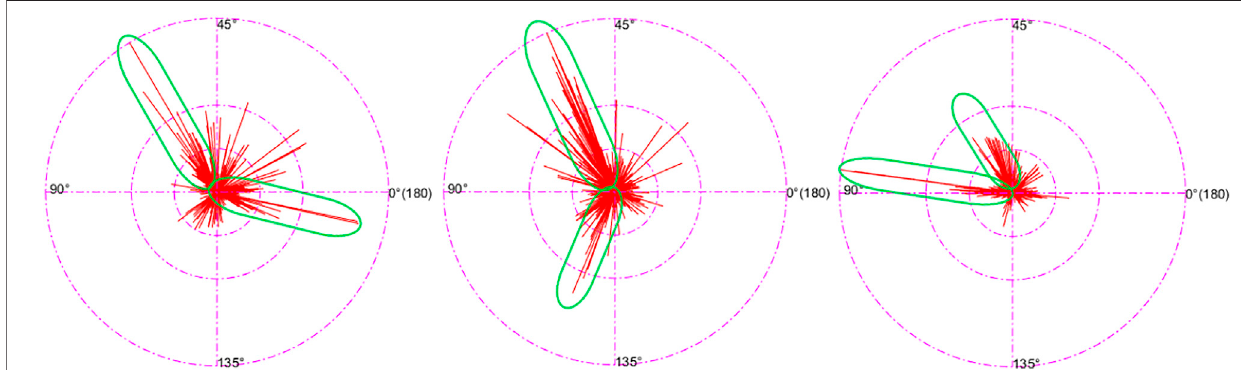
FIGURE 5 | Line angle and length distribution diagram.